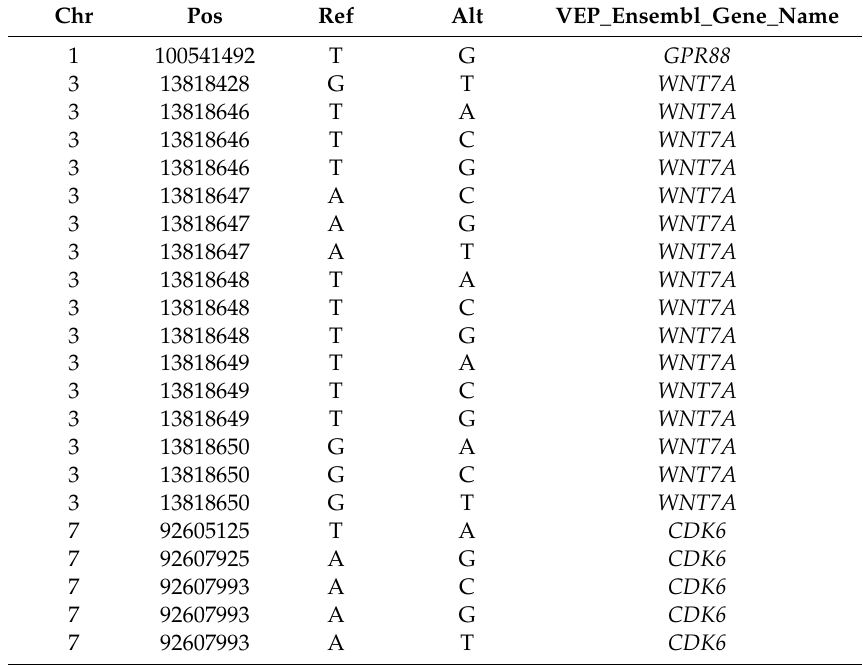
Table 1. Identified variants located in 3 (cid:48) UTR regions that alter miRNA targeting based on dbMTS. Chr Pos Ref